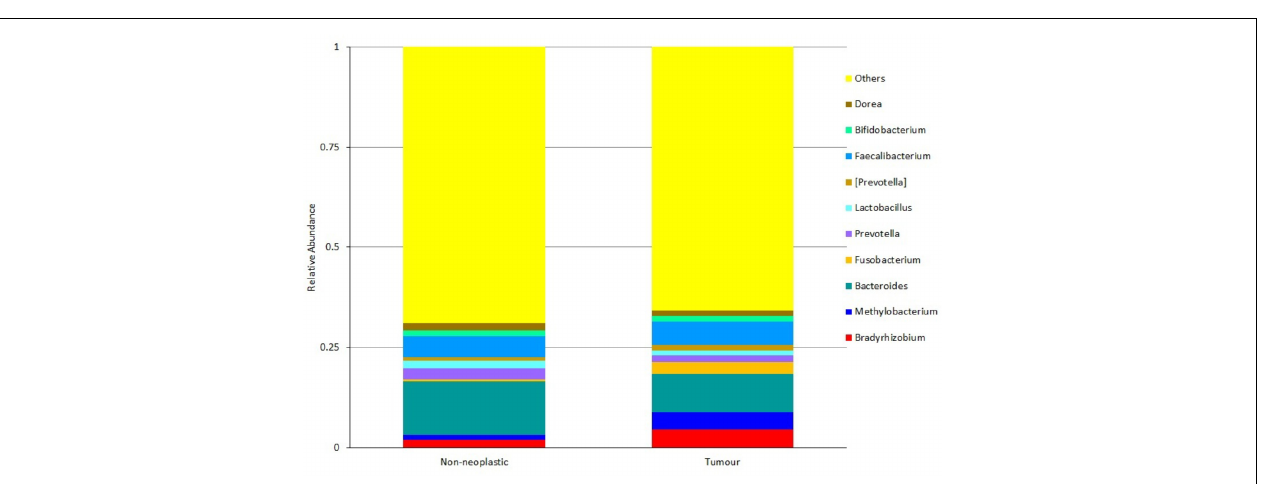
FIGURE 5 | Microbiota structures in the non-neoplastic mucosae and tumours at genus